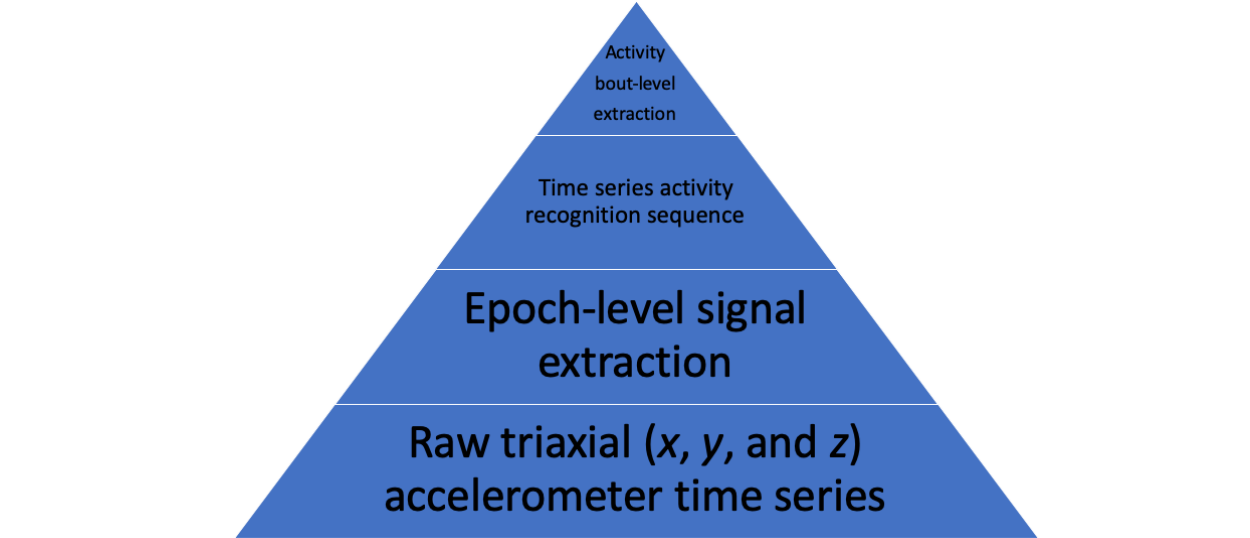
Figure 2. Hierarchy of physical activity representations.